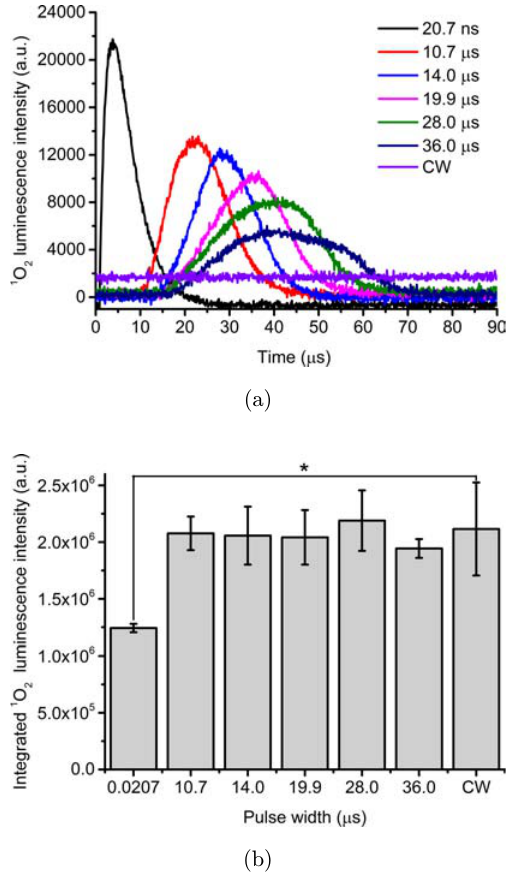
Fig. 4. (a) The typical time-resolved 1 O 2 luminescence kinet- ics after background subtraction from RB 1.00 (cid:1) M in PBS, and (b) the corresponding integrated 1 O 2 luminescence intensity with pulse width of 20.7ns at 523 nm, and pulse widths of 10.7, 14.0, 19.9, 28, 36 (cid:1) s and CW at 532 nm. * P < 0 : 05.